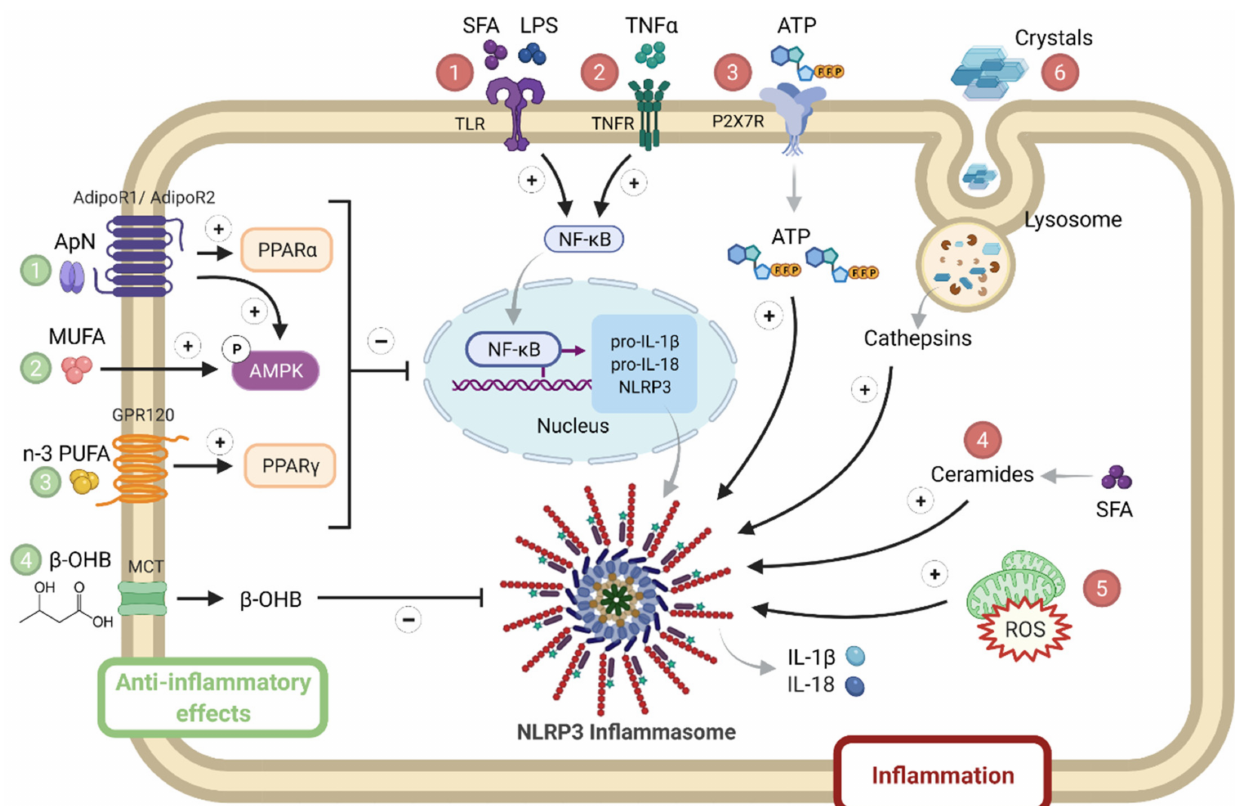
Figure 4. NLRP3 priming and activation in metabolic syndrome. Several activators of either priming or NLRP3 complex formation are numbered in red. They include SFA, LPS 1 (cid:13) , inflammatory cytokines such as TNF α 2 (cid:13) , stress molecules such as ATP 3 (cid:13) , ceramides 4 (cid:13) and ROS 5 (cid:13) , as well as crystals 6 (cid:13) . By contrast, inhibitory hormonal or metabolic signals are numbered in green: they include adiponectin (1), MUFA (2) or n-3 PUFA (3), or ketone bodies ( β -OHB) (4). Adiponectin binds to AdipoR1 (predominantly expressed in skeletal muscle) or to AdipoR2 (predominantly expressed in liver) to activate AMPK or PPAR- α signaling, respectively. MUFA and PUFA activate AMPK and PPAR- γ signaling, respectively. β -OHB is produced by the liver and is used as fuel by other tissues (such as muscle), where it enters via a MCT. β -OHB, β - hydroxybutyrate; MCT, monocarboxylate transporter; MUFA, mono unsaturated fatty acids; PPAR, peroxisome proliferator activated receptor; PUFA, poly unsaturated fat; SFA, saturated fatty acids. Symbols in circles indicate: ‘P’, phosphorylation; ‘+’, activation; and ‘ − ’,